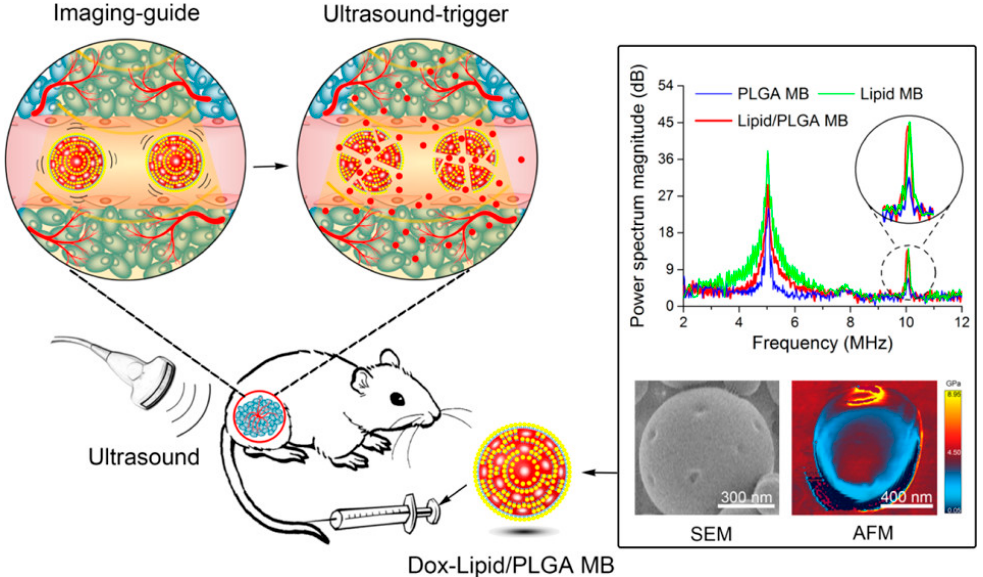
Figure 12. A multiparous lipid-PLGA hybrid nanoparticle synthesis for diagnosis and treatment. Reprinted with permission from [143], Copyright © 2019, American Chemical Society.